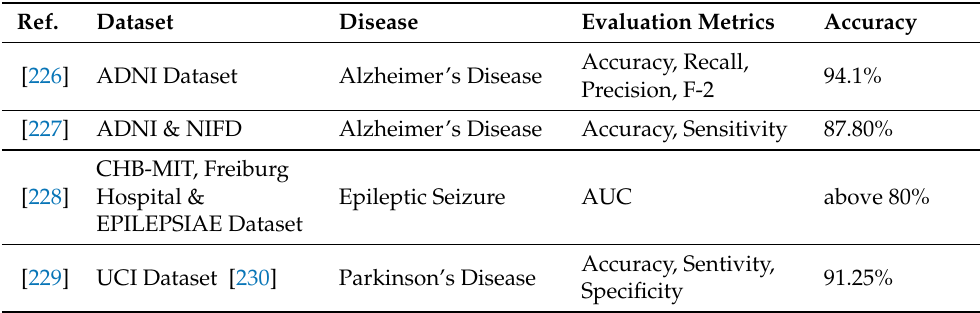
Table 11. GAN classifier result analysis on various